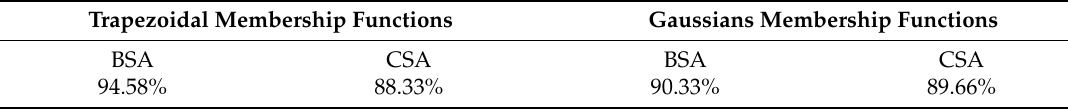
Table 6. Comparison of BSA and CSA averages.